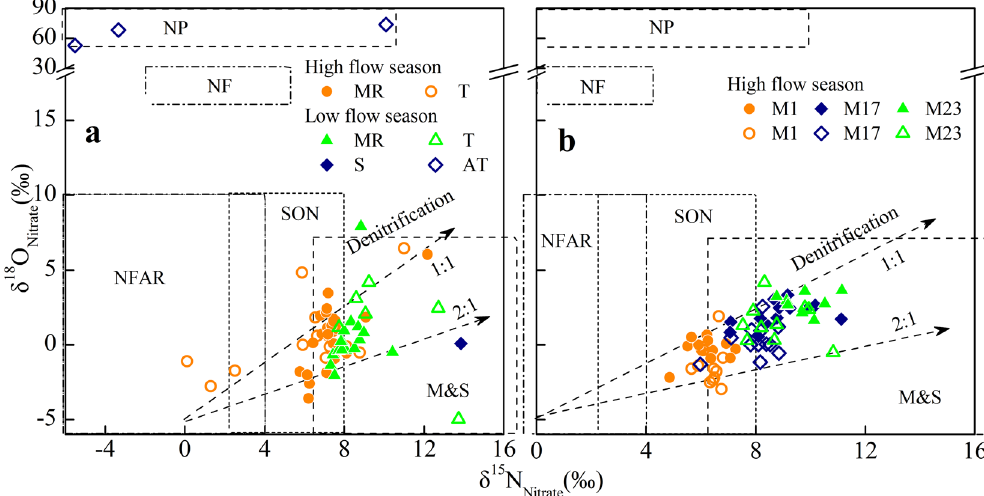
Figure 7. Relationship between δ 15 N nitrate and δ 18 O nitrate values during 2010 to 2011 ( a ) and at three monthly sites during 2012 to 2014 ( b ). MR indicates main reaches samples. T stands for tributaries samples. S stands sewage waste sample. AT stands for atmospheric precipitation samples. Other abbreviations for sources were introduced in the